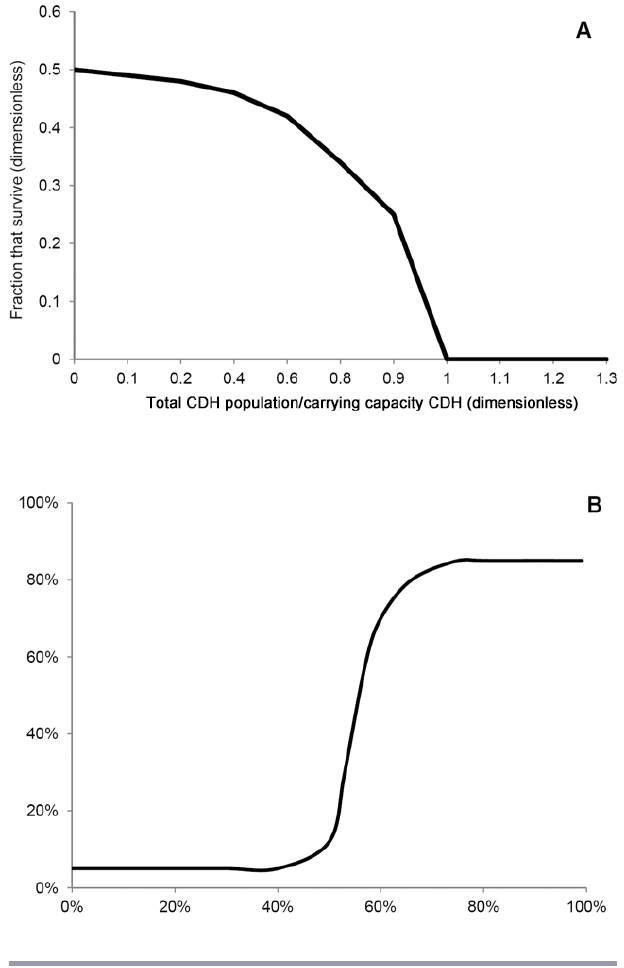
Fig. 3 . (A) The survival function for newly recruited individuals is a smooth curve based on the Beverton-Holt equation used to model fish populations, wherein recruitment is based primarily on the population of mature, reproducing individuals. This curve shows survival of newly recruited individuals compared to the total pen shell population in the model. (B) Type III functional response curve that drives the foraging behavior of the fishers in switching their relative effort between the two pen shell species. CDH refers to Callos de Hacha, or the entire pen shell population, including both species Atrina tuberculosa and Pinna rugosa